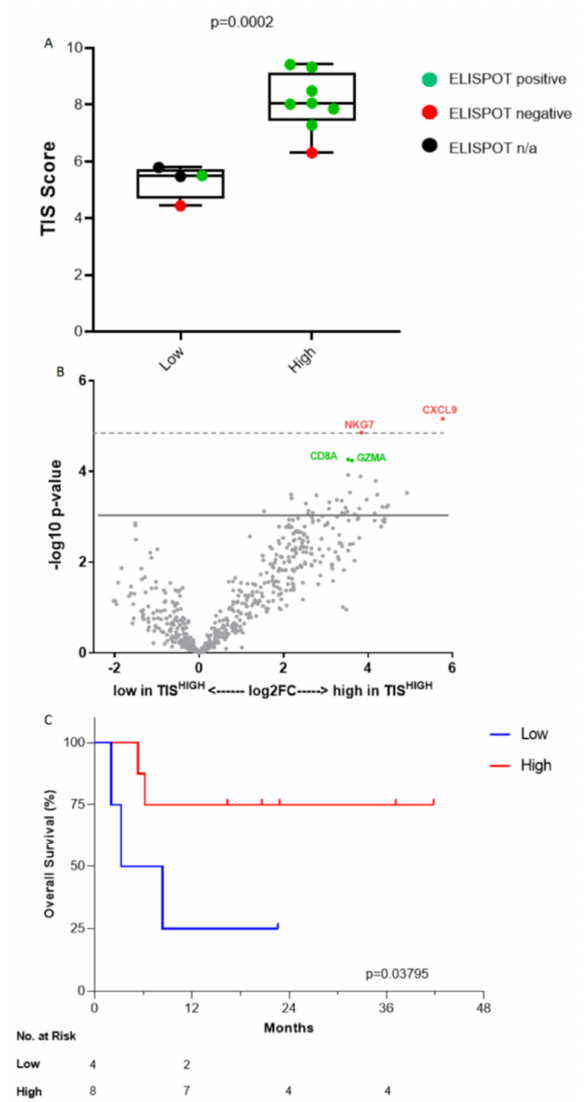
Commented [M116]: Please check are all Figure 4. γ -IFN-ELISPOT reactivity stratified by tumor inflammation score HIGH (TIS) vs. TIS LOW . Figure 4. γ -IFN-ELISPOT reactivity stratified by TIS HIGH vs. TIS LOW . Whiskers represent minimum 226 Whiskers represent minimum and maximum TIS scores. Statistical analyses of TIS scores were and maximum TIS scores. Statistical analyses of TIS scores were performed using unpaired T-tests 227 performed using unpaired T-tests with Welch correction. ( A ) Volcano plot of p -value versus log2 fold change in the differential expression between TIS HIGH and TIS LOW . The test for differential expression was done by fitting the log2 normalized count to the response with linear model. The p -values were adjusted by the Benjamini and Yekutieli (BY) adjustment. Dots corresponding to genes that are significant at p < 0.5 (dashed line) are labeled in red. Solid line represents p < 0.10 ( B ). Overall survival relationship of Vigil treatment stratified by TIS HIGH vs. TIS LOW ( C